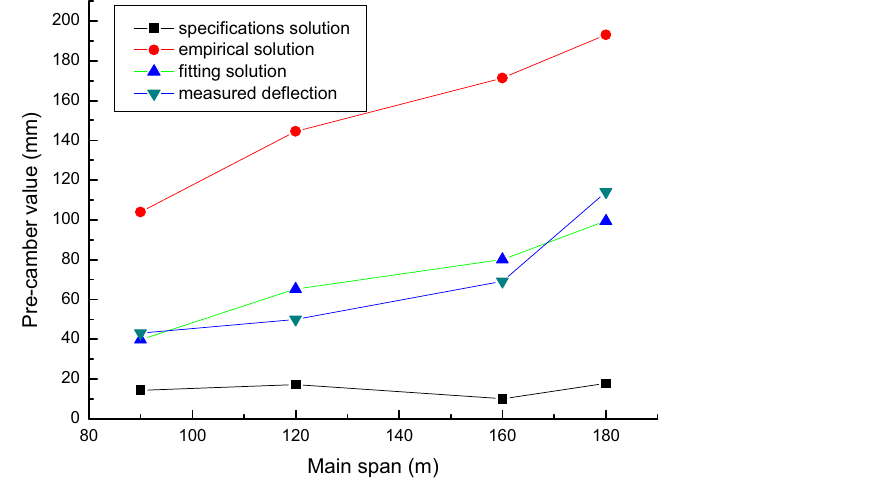
Figure 8. Comparison of mid-span